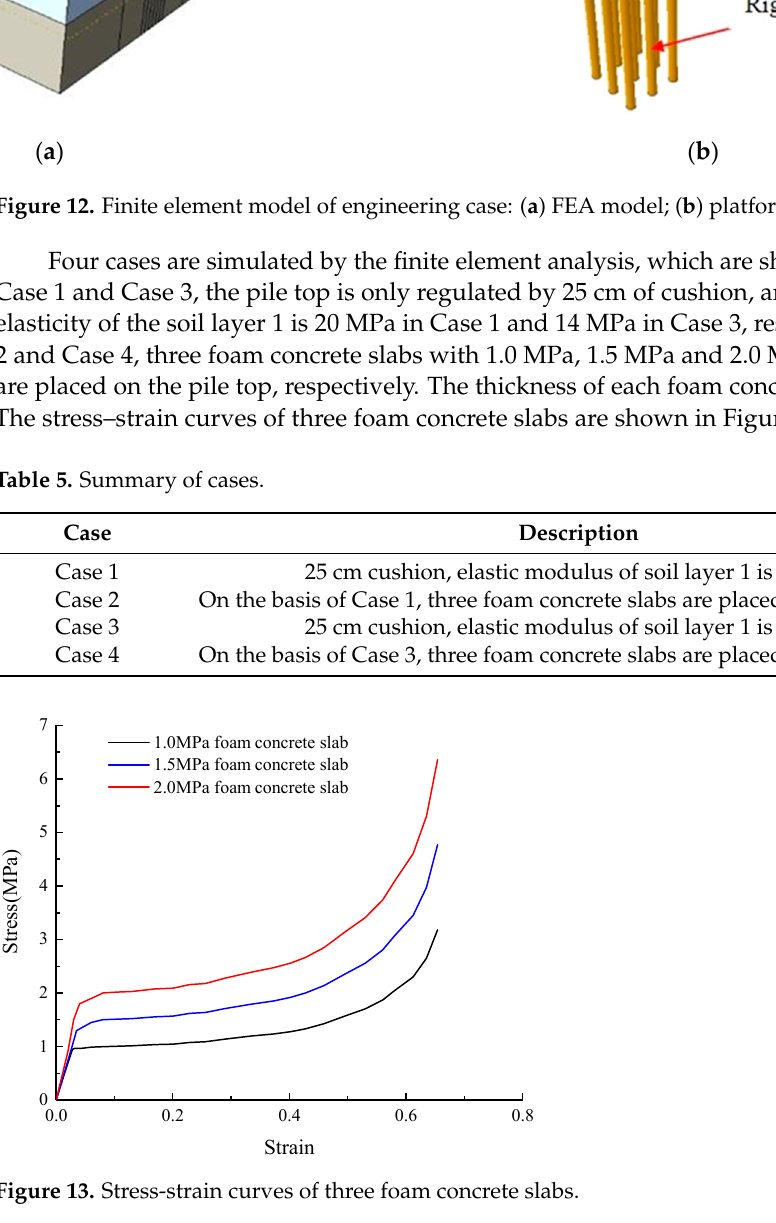
Figure 14. Load–total settlement curve.